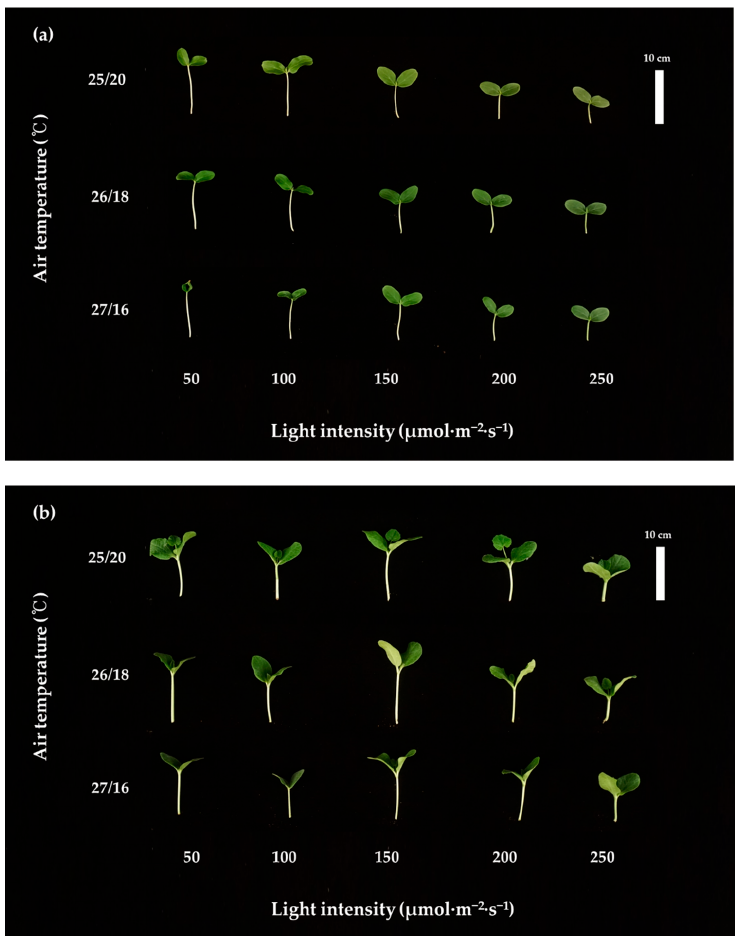
Figure 4. Cucumber scions ( a ) and rootstocks ( b ) cultivated under different air temperature and light intensity conditions in a PFAL. Table 1. Growth of cucumber scions as affected by the different air temperature and light intensity at 6 days after cultiva- tion in a PFAL.